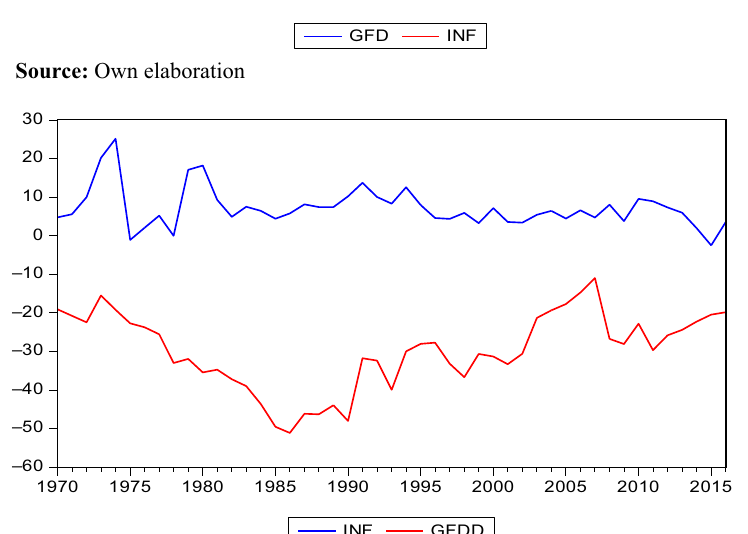
Figure 1. INF rate and fi scal